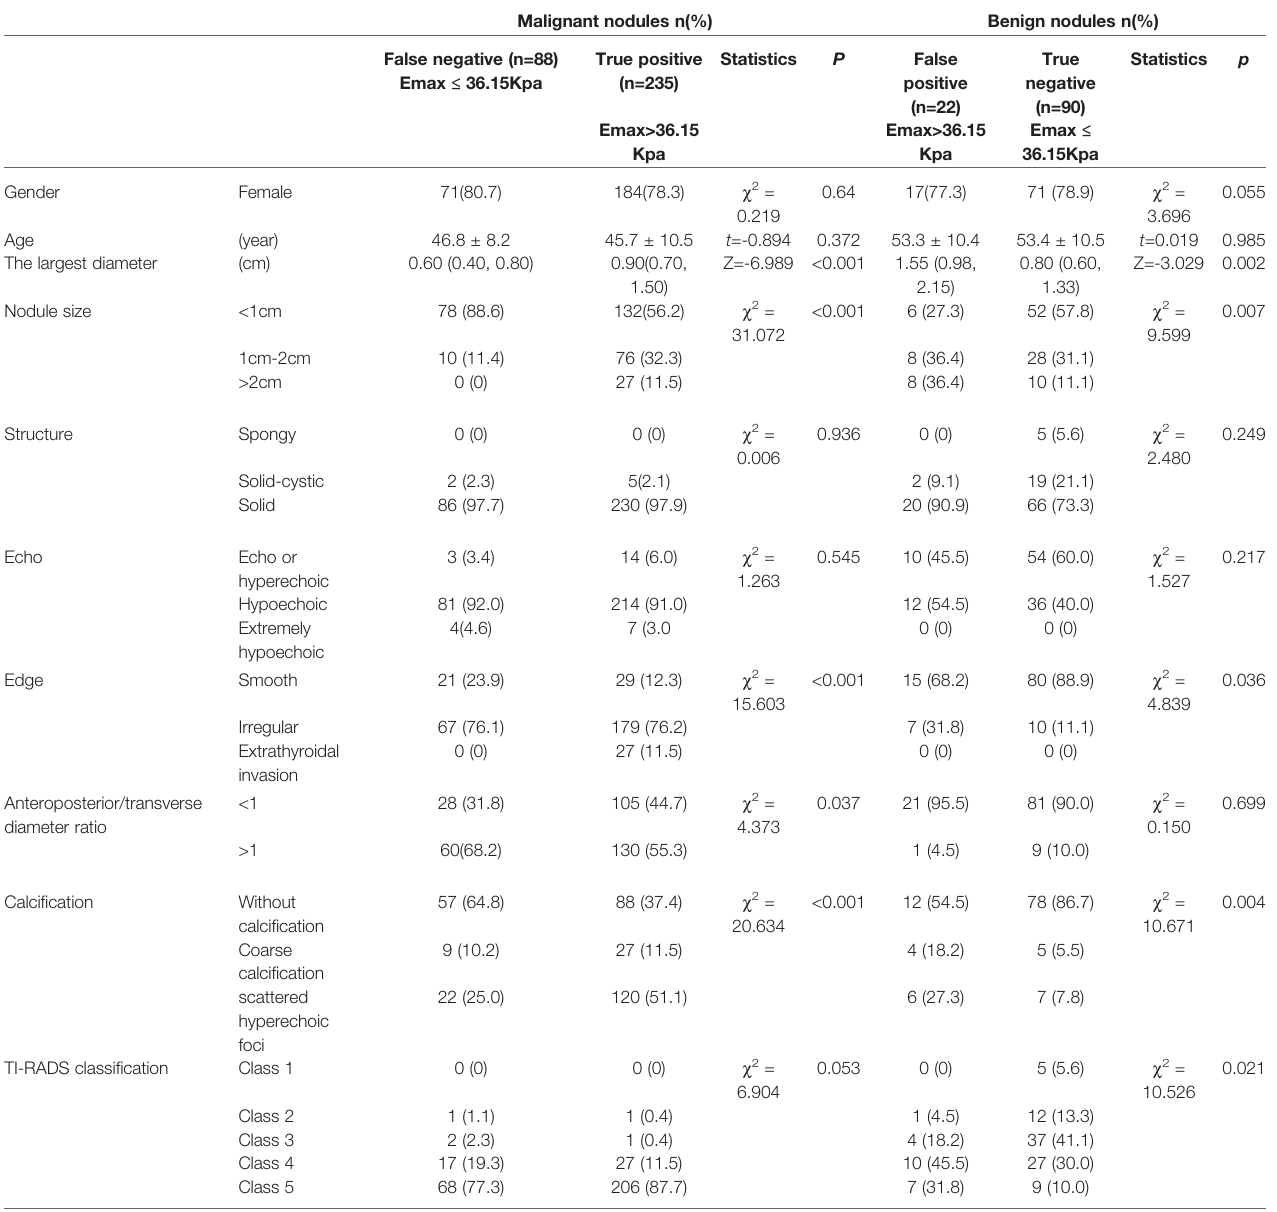
TABLE 3 | Comparison of the related characteristics of thyroid nodule for diagnosis by